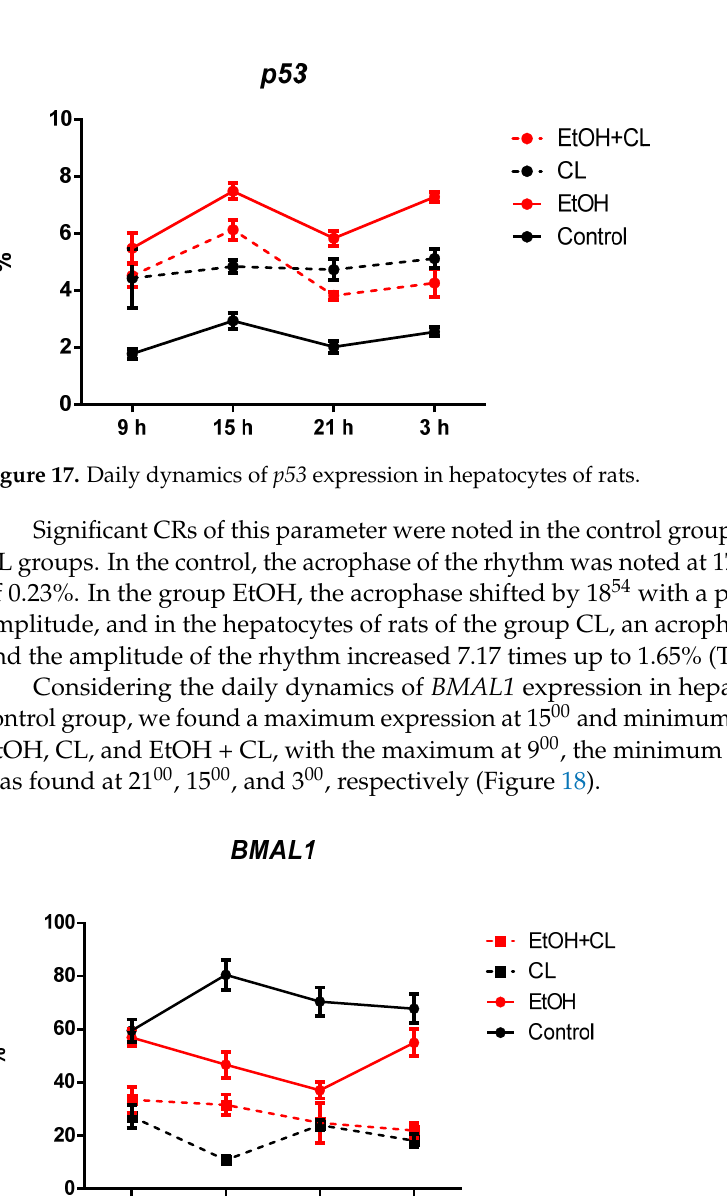
14 of 27 Figure 16. Daily dynamics of Ki-67 expression in hepatocytes of rats. Significant CRs were noted in the control—acrophase at 3 47 with an amplitude of 0.29%—and in the liver of rats of groups EtOH and CL with acrophases of 10 40 and 10 06 and 3,6 times and 2.13 times increased amplitudes (1.04% and 0.62%), respectively (Table